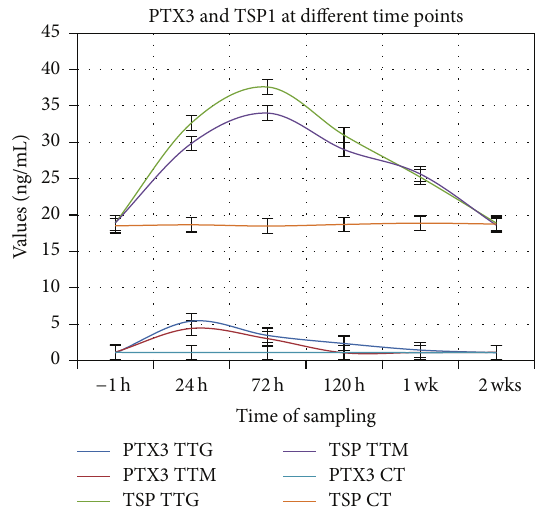
Figure 1: Dynamics in time of PTX3 and TSP1 levels in TTG and TTM. Levels in ng/mL, M ± SD. Maximum levels for PTX3 at 24 h and for TSP1 at 72 h in both TTM and